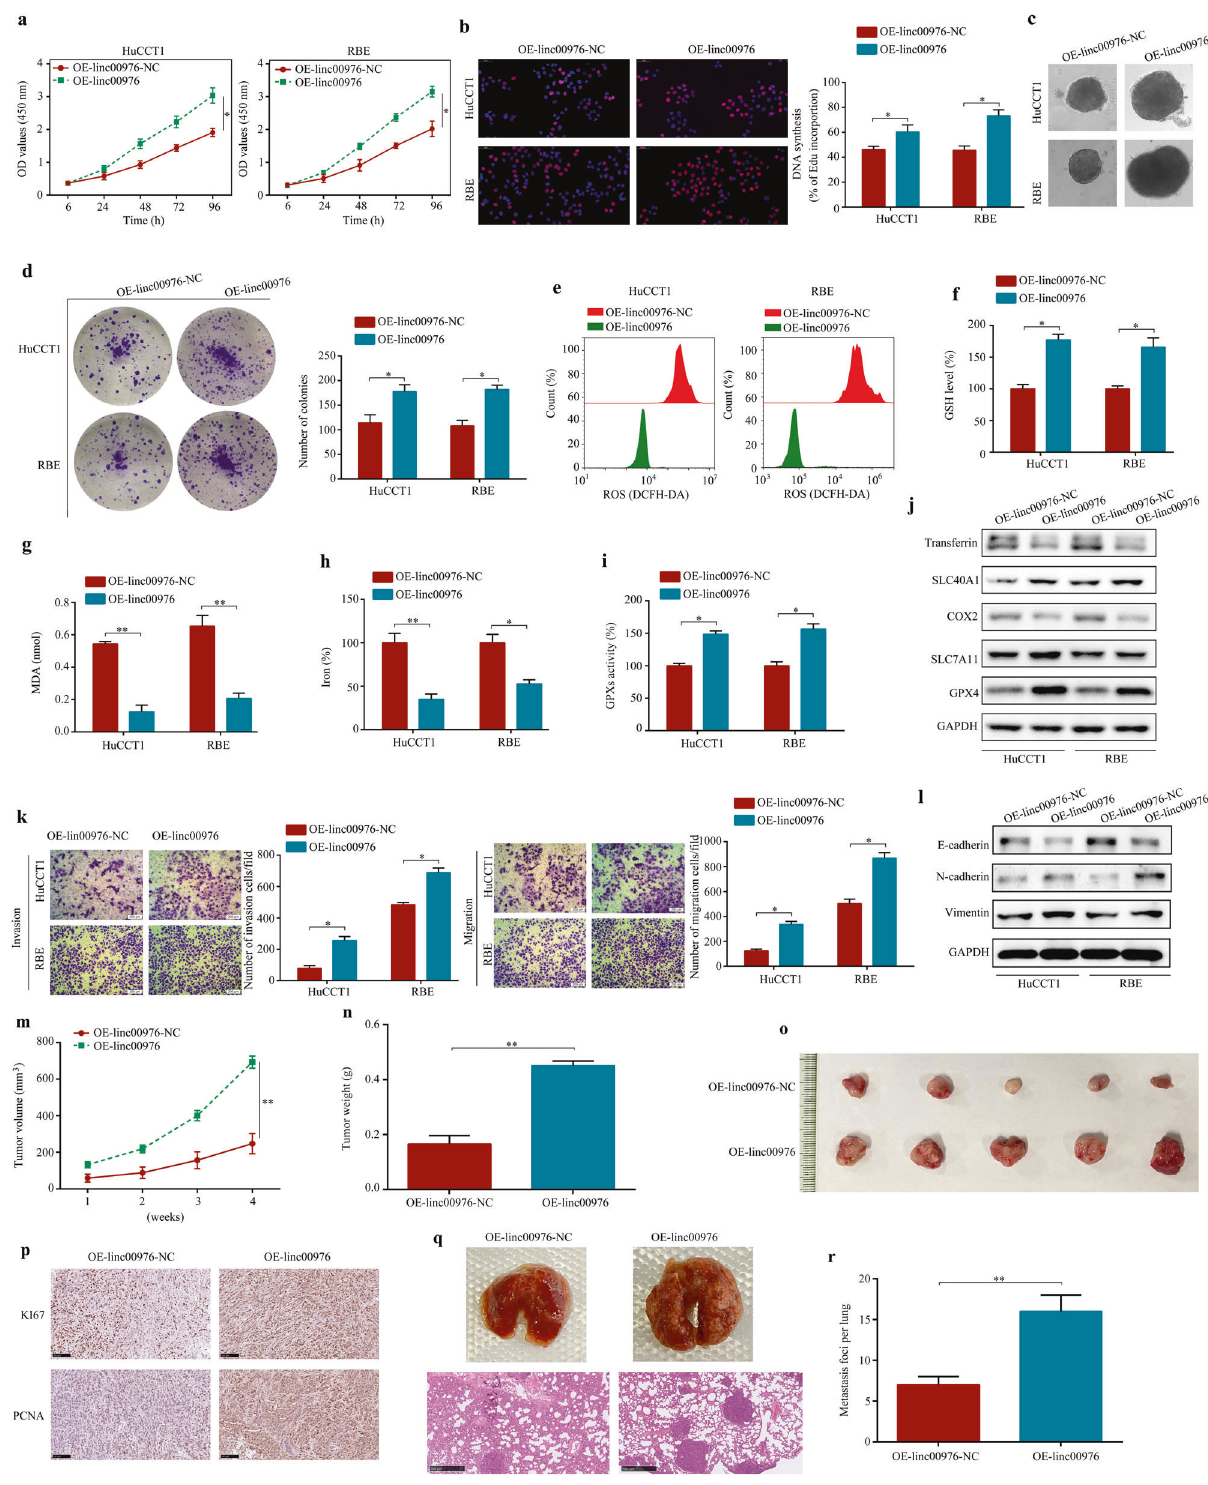
knockout, consistent with an increase in lipid peroxide levels associated with elevated ferroptosis activity (Fig. 6i). Notably, linc00976 knockout markedly reduced GSH activity and enhanced levels of oxidized GSH (GSSG). As key components of the GSH synthesis process [15], γ -glutamyl cysteine, cysteinyl glycine, and cysteine levels were signi fi cantly reduced, whereas no signi fi cant changes in cystine or glutamic acid levels were detected (Fig.